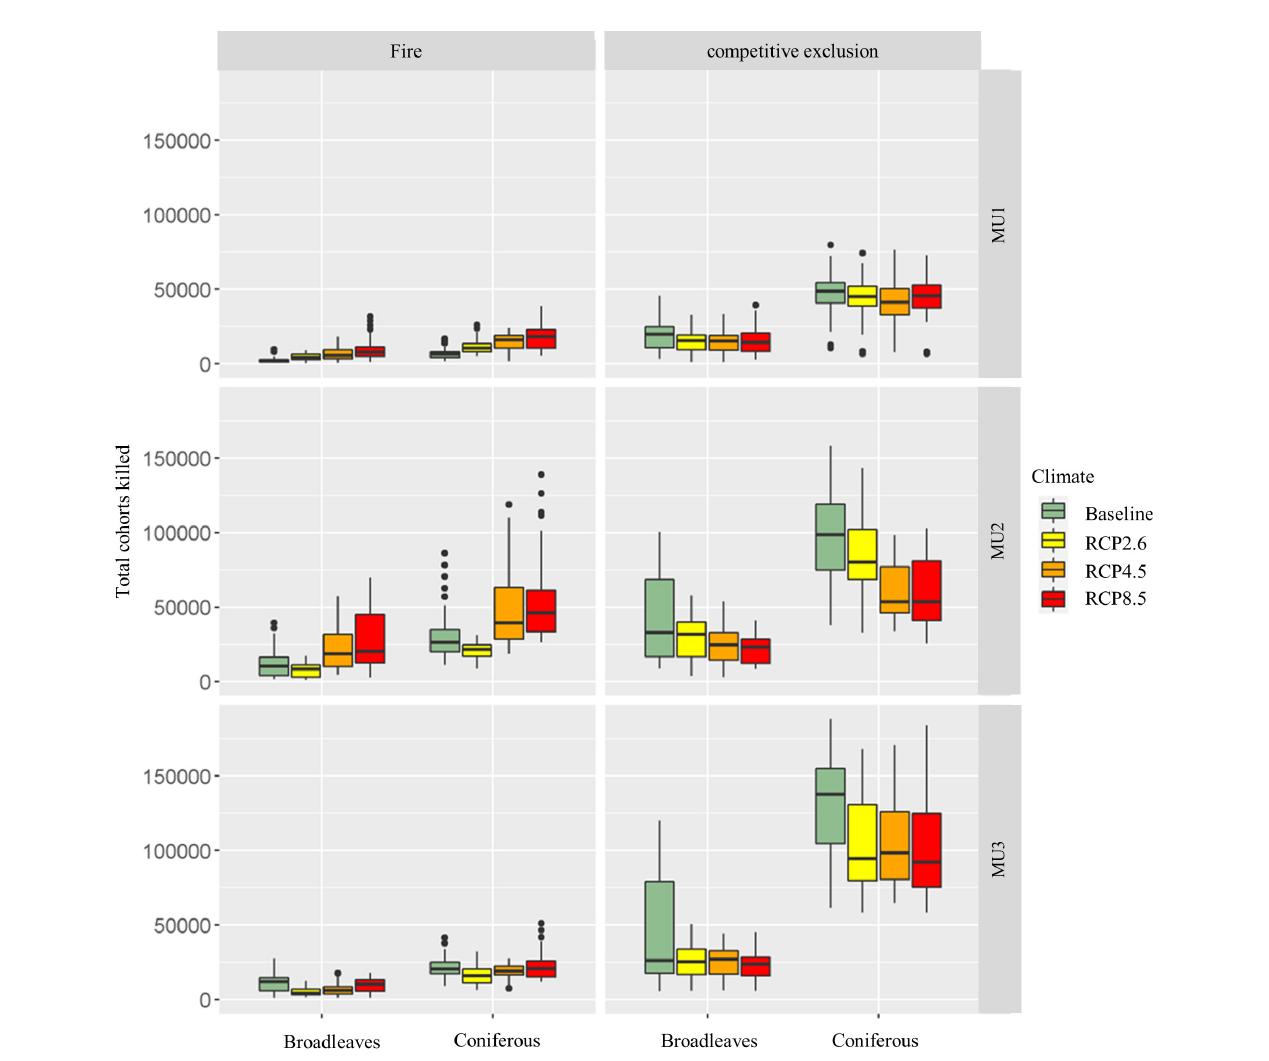
FIGURE10 Fires and competitive exclusion mortality boxplots and averages for the entire study period (2010–2310) under climate change scenarios in the three management units.